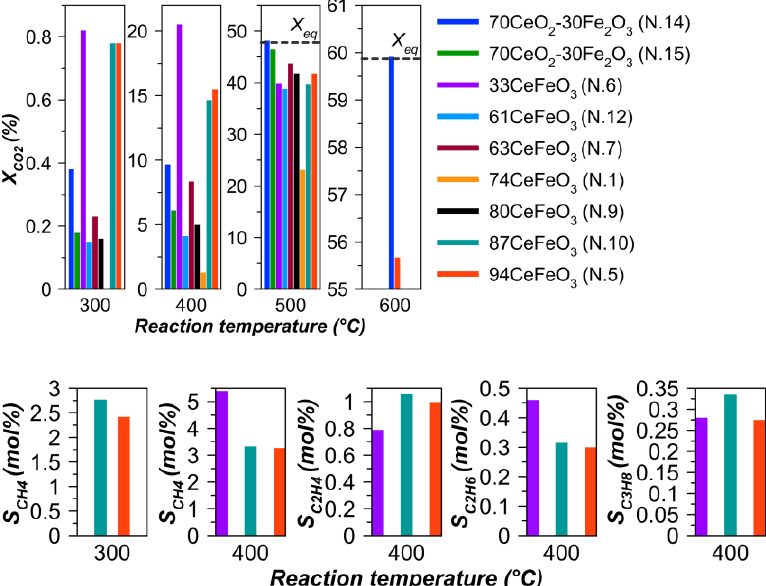
Figure 8. Dependence of CO 2 conversion and selectivity to hydrocarbons on temperature at H 2 :CO 2 :N 2 = 3:1:1, WHSV = 10 000 mL·g – 1 ·h – 1 . CO selectivity is 100 mol%, except for samples additionally generating hydrocarbons (N. 5, 6, 10).